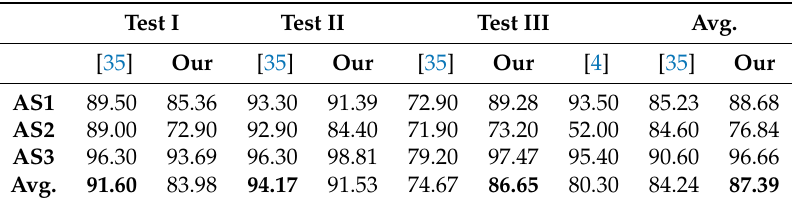
Table 5. Comparisons to state-of-the-art research works using the MSR action dataset of [35]. Results denote accuracy (%).